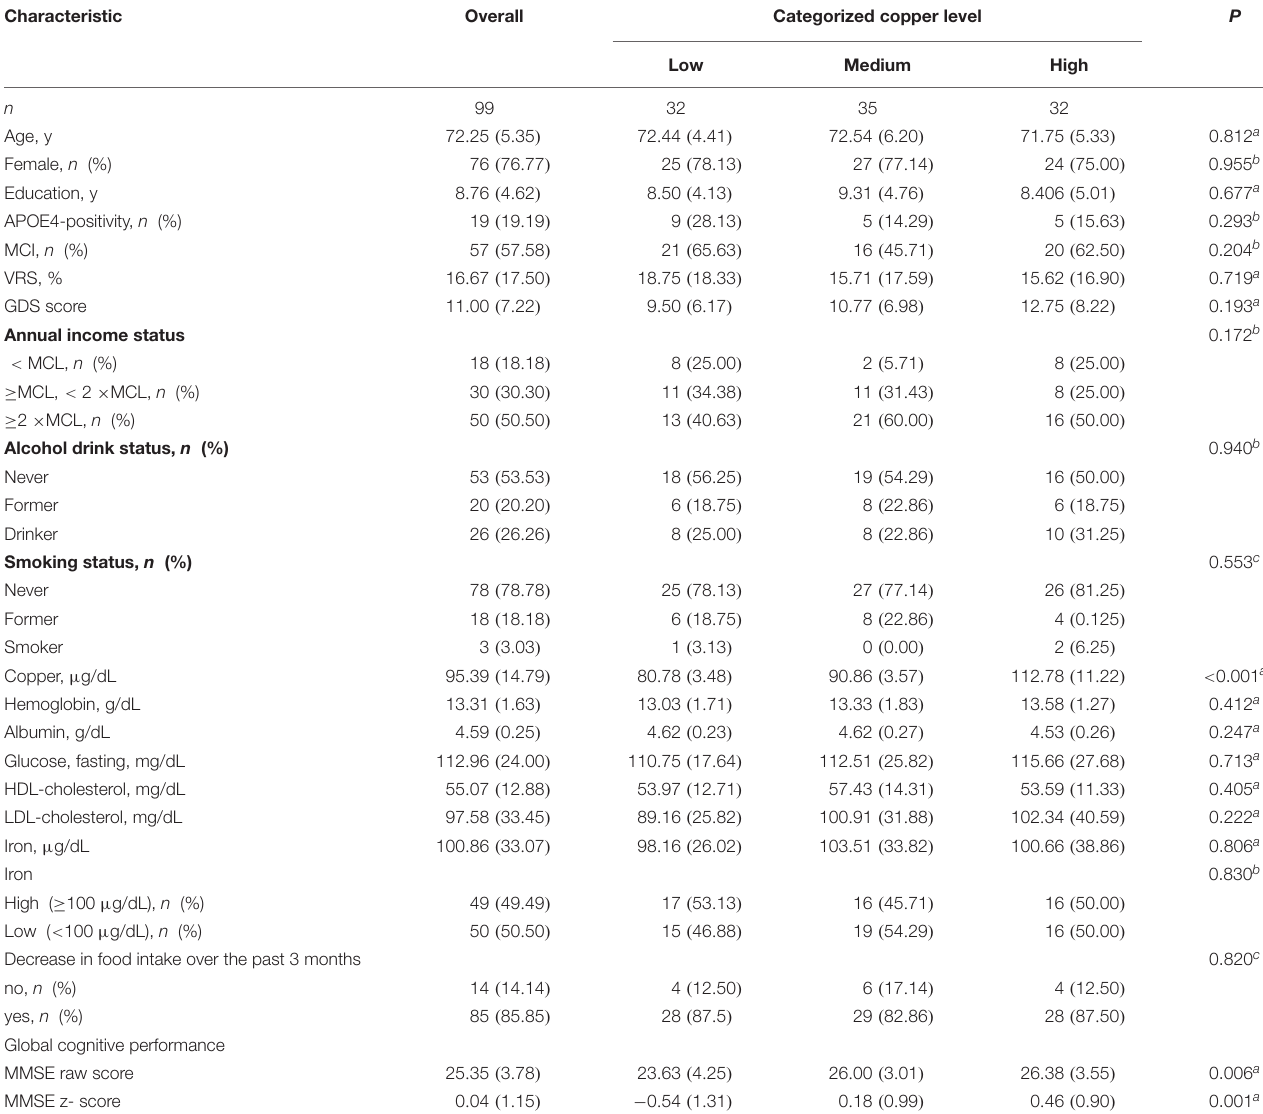
TABLE 1 | Demographic and clinical characteristics of non-demented participants by the categories of serum copper. Characteristic